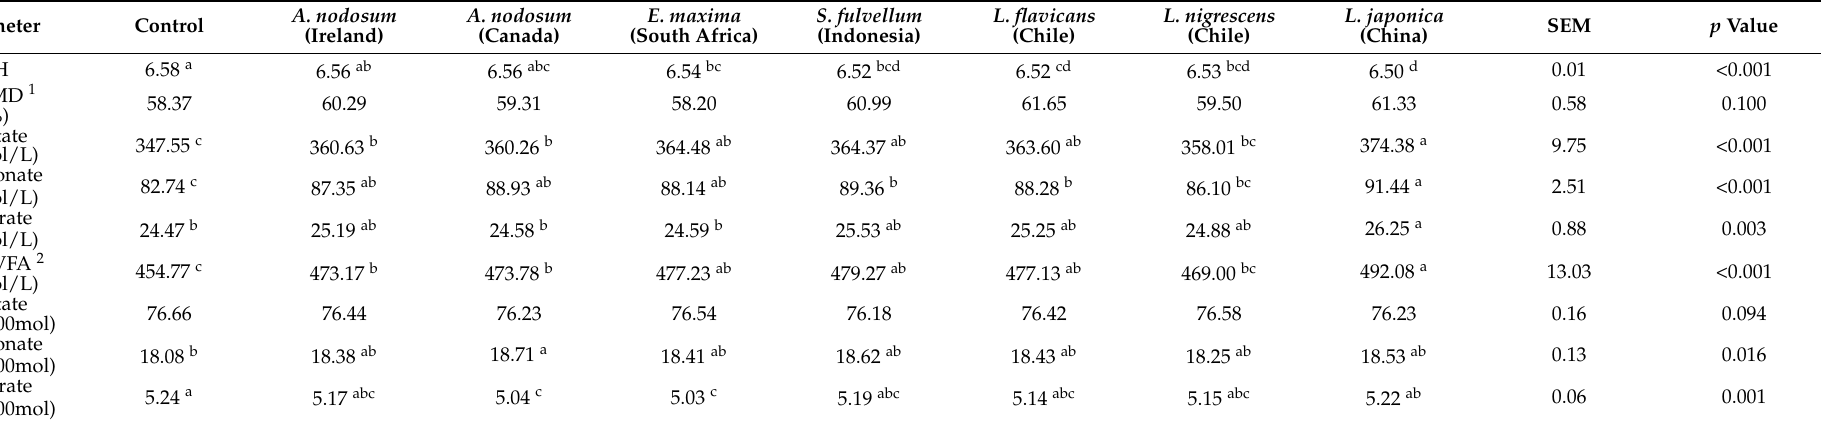
Table 5. Effect of different brown seaweeds as feed additives on rumen fermentation characteristics from 24 h in vitro incubation ( n = 12) (Experiment 1).